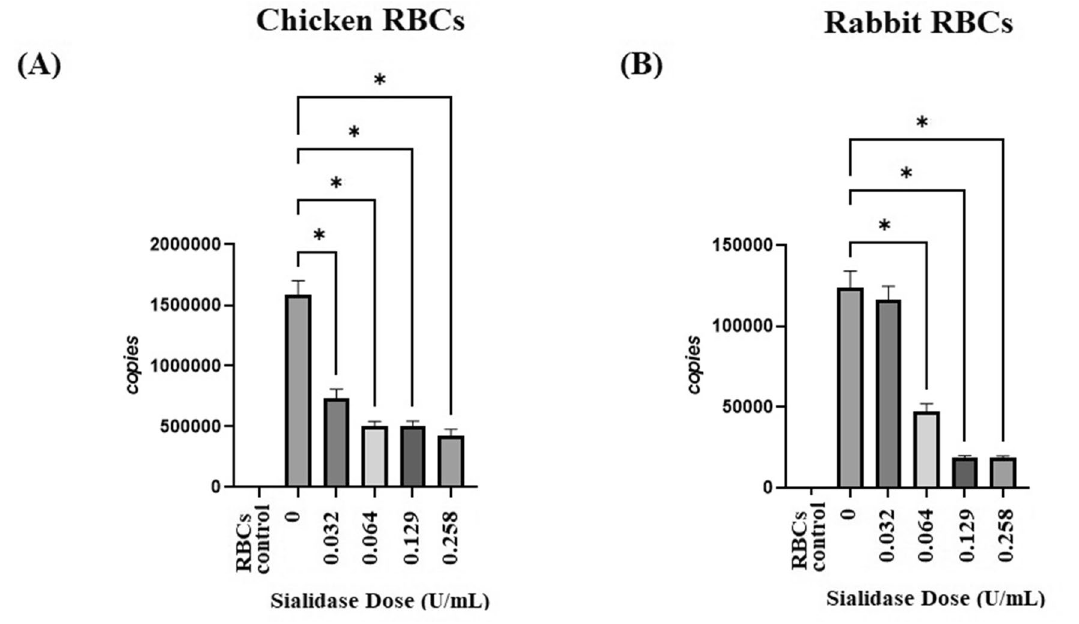
Figure 10. Viral copy number of H9 genes of the viruses that bind to red blood cells. ( A ) chicken red blood cells and ( B ) rabbit red blood